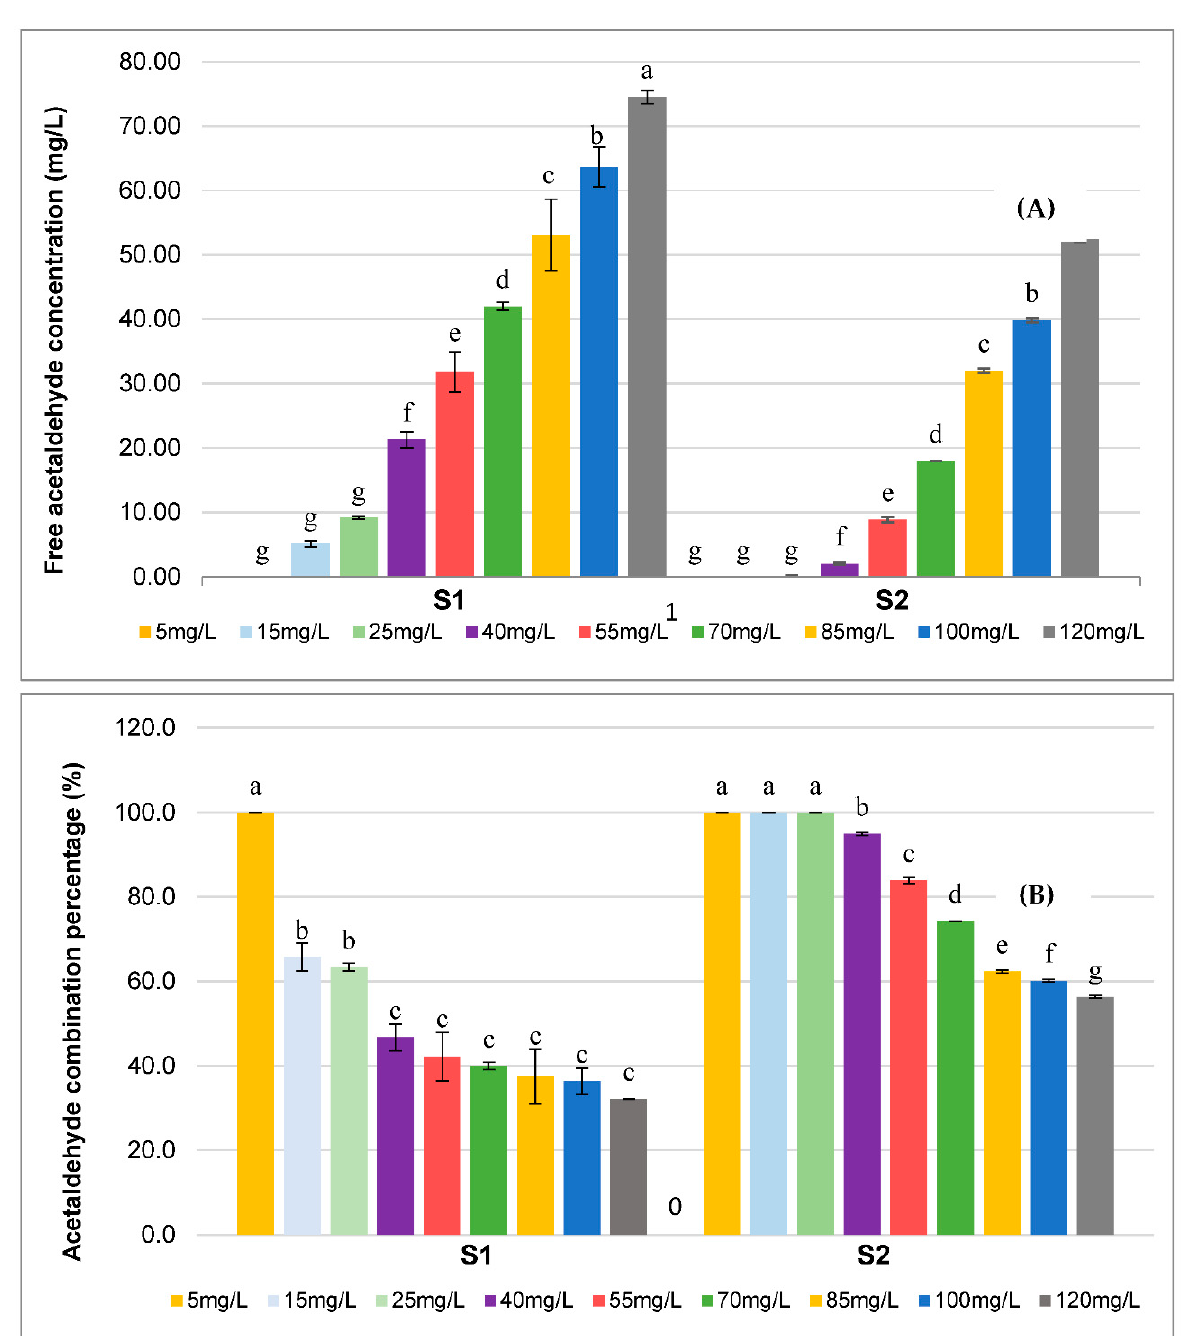
Figure 1. Evolution of free acetaldehyde concentration ( A ) and the corresponding combination percentages for HCATA samples ( B ). Different letters indicate significant differences between samples according to Tukey’s test ( p < 0.05).